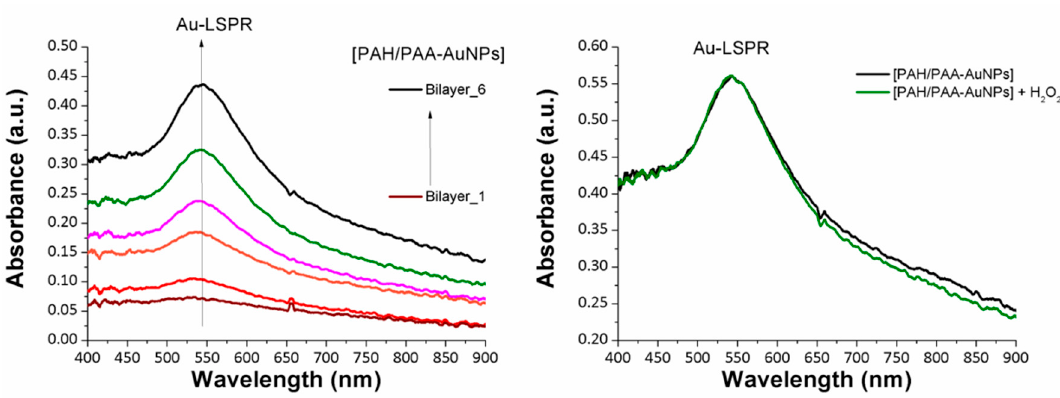
Figure 7. ( Left ) UV-Vis spectra of the optical fiber sensor as a function of the number of bilayers added during the fabrication of the Layer-by-Layer films. The curves are plotted from 1 up to 6 bilayers, respectively. ( Right ) UV-Vis spectra of the optical fiber sensor before (black line) and after (green line) exposure to a hydrogen peroxide concentration of 5000 ppm.